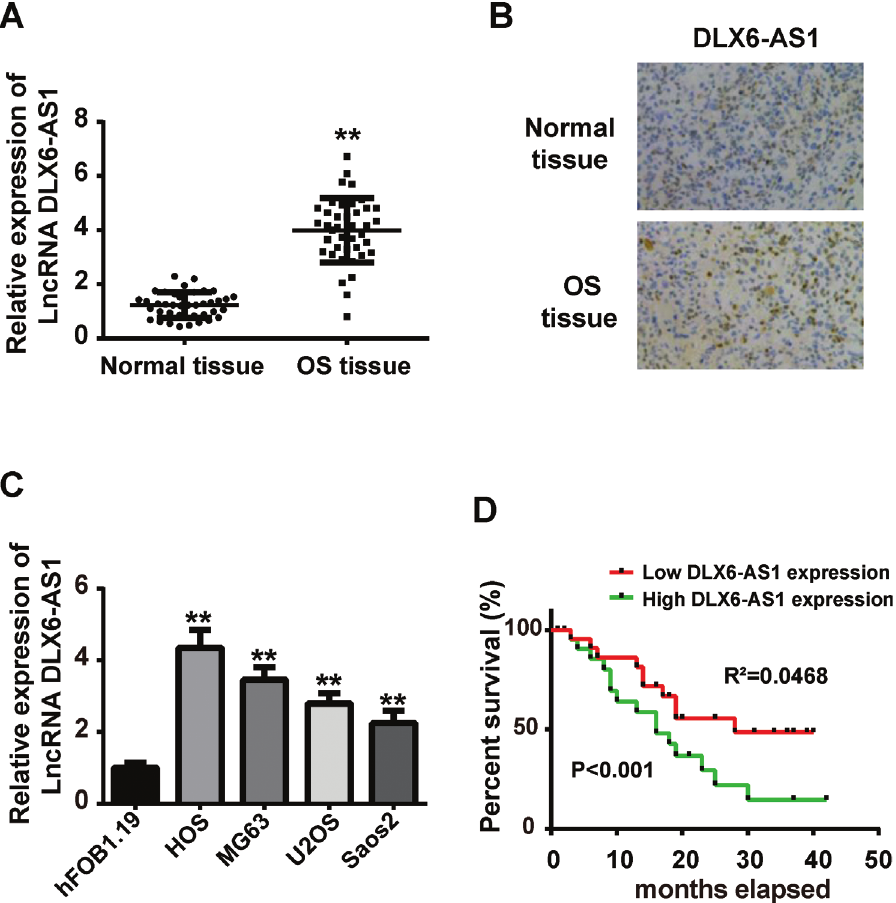
Fig. 1. Overexpression of LncRNA DLX6-AS1 in OS cell and tissue lines. (a) RT-qPCR measured DLX6-AS1 expression in OS tissues and adjacent normal tissues. (b) ISH detected DLX6-AS1 expression in OS tissue and adjacent normal tissue. (c) DLX6-AS1 expression in the normal human osteoblasts cell line (hFOB 1.19) and other OS cell lines (HOS, MG63, U2OS and Saos2) were measured by RT-qPCR. (d) High expression levels of DLX6-AS1 in OS patients predicted poor prognosis. ** P < 0.01, versus normal tissue or